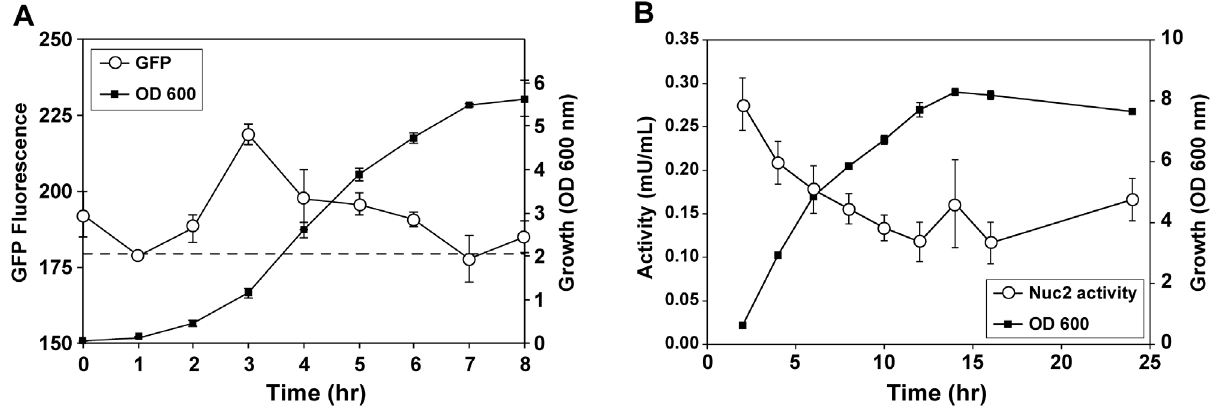
Figure 5. Nuc2 is expressed at low levels during growth. A . Monitoring changes in fluorescence of a P nuc2 -sGFP transcriptional reporter over time (open circles) in comparison to growth (black squares). Dotted line indicates level of background fluorescence of growth media. B . Changes in surface Nuc2 activity (open circles) present in a S. aureus USA300 LAC nuc mutant over time as measured by whole-cell FRET assay.